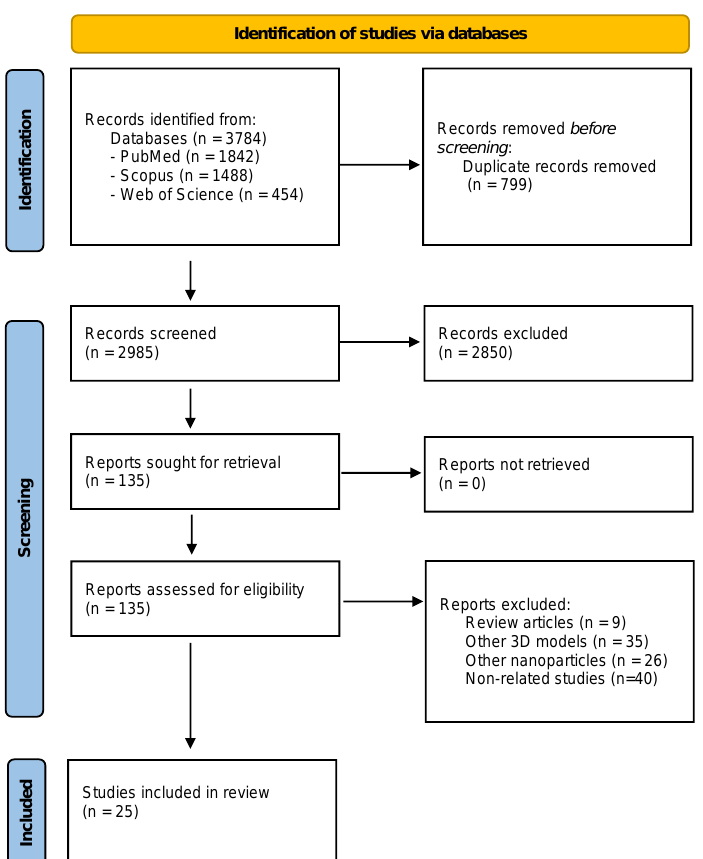
Figure 2. Prisma Flow diagram of the methodology used for literature search and studies selection in this systematic review .